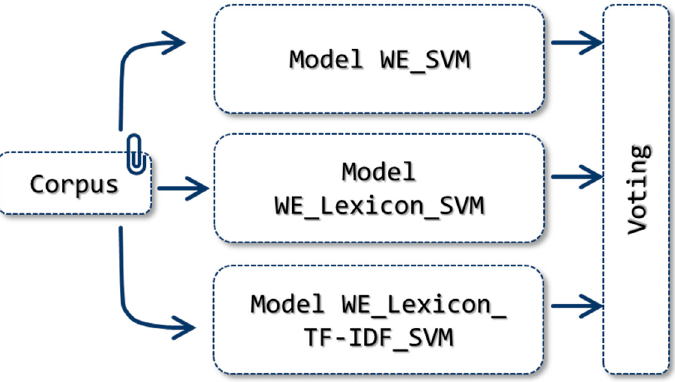
Figure 12. WE_Lexicon_TF-IDF_E_SVM Model.